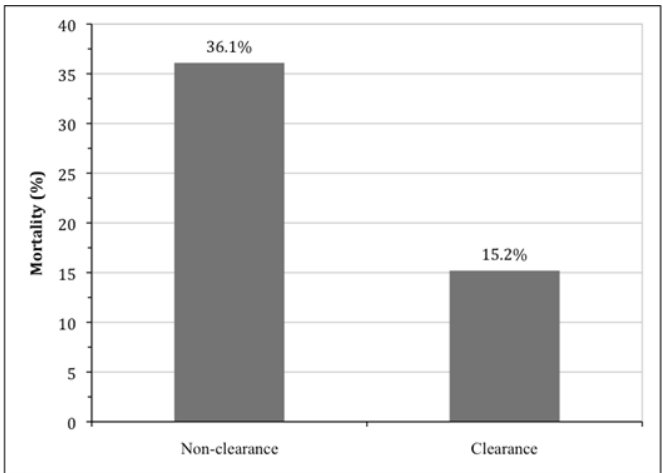
Figure 2. Mortality rates by lactate clearance group. 28-day in-hospital mortality rates were significantly lower among patients who cleared lactate (15.2% mortality) compared with those who did not (36.1% mortality,